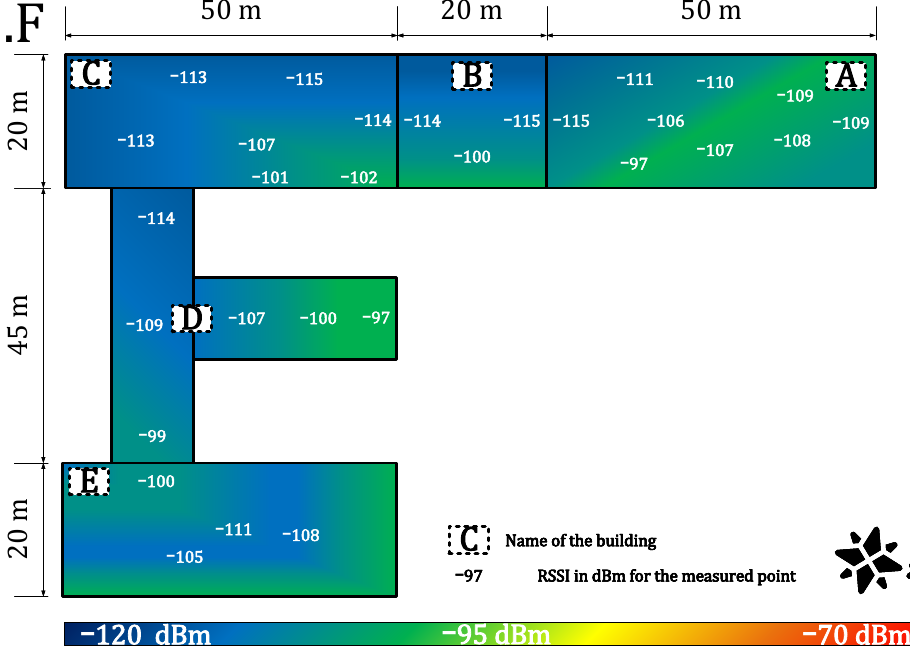
Figure 11. Private network coverage and signal propagation on the third